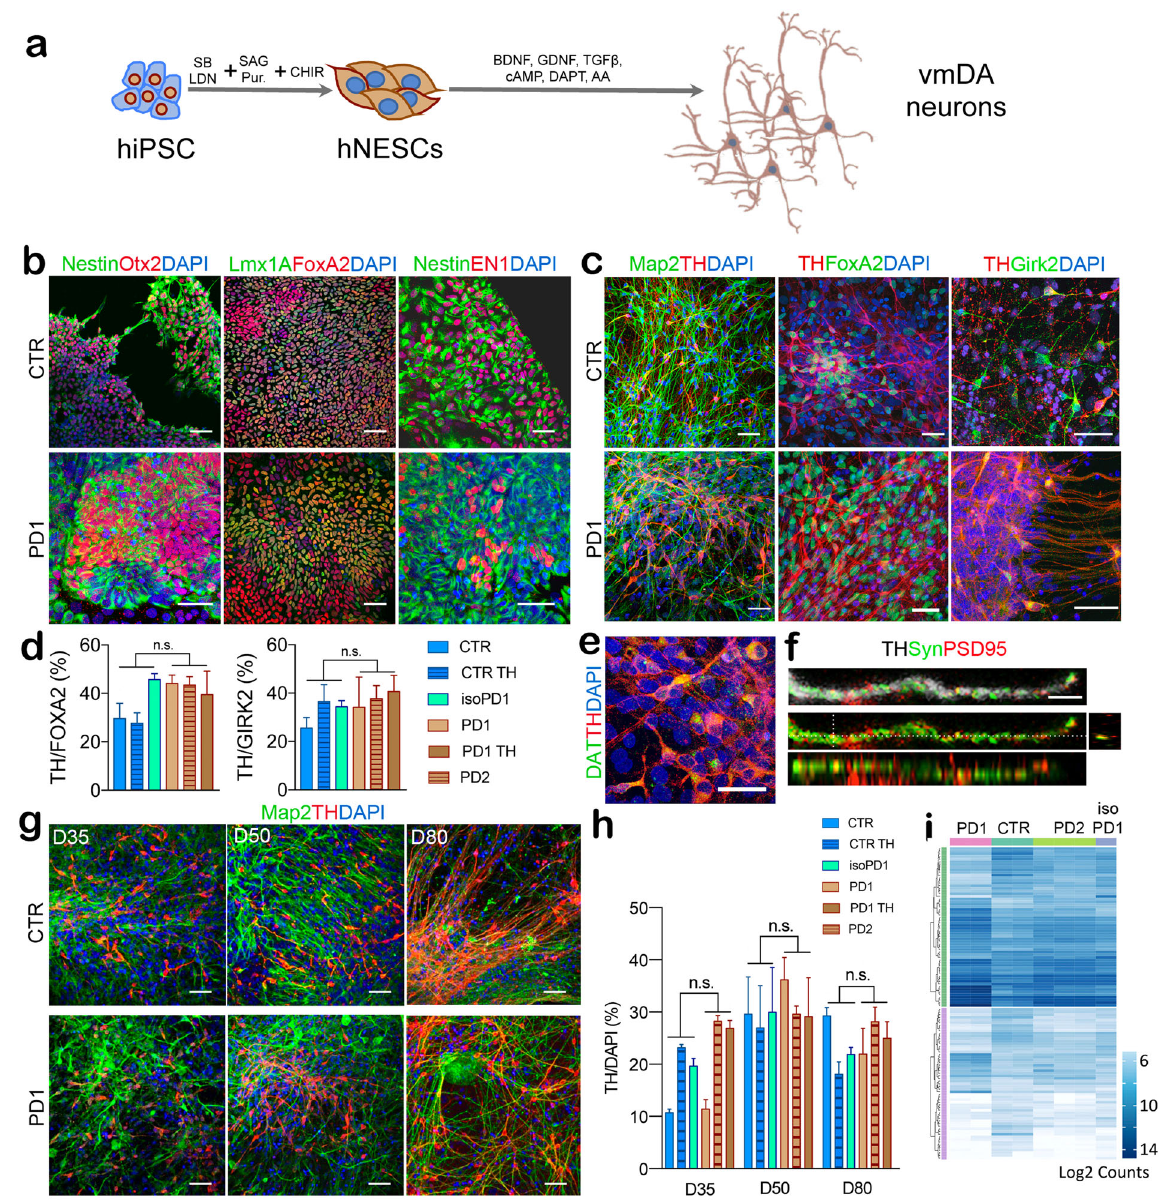
Fig. 1 Generation of ventral midbrain (VM) dopaminergic neurons from human iPSCs. a Scheme showing VM dopaminergic neurons differentiation protocol. b Representative immuno fl uorescence (IF) images of CTR (SP11) and PD1 (SP12) NPCs at day 12 of the differentiation process. iPSC-derived neural cultures express fl oor plate progenitor markers, such as Lmx1A, FoxA2, Otx2, Nestin, and EN1. c Representative IF images of CTR (SP11) and PD1 (SP12) differentiated neuronal cultures expressing neuronal markers (MAP2, TH) and midbrain-type DA markers (FoxA2 and Girk2) at day 50. Scale bar is 50 μ m. d Percentage of TH/FoxA2 and TH/Girk2 vmDAn at day 50 of all the lines [CTR (SP11), CTR TH (SP11 TH), gene-edited isoPD1 (SP12 wt/wt), PD1 (SP12), PD1 TH (SP12 TH), PD2 (SP13)]. A number of independent experiments n = 3. e – f Representative images of neuronal cultures at D50 expressing speci fi c markers of maturation: e DAT (dopamine transporter) (scale bar, 50 μ m); and f PSD95 (post-synaptic marker, red) and synapsin (synaptic marker, green). Orthogonal views show colocalization (scale bar, 10 μ m). g Representative images of CTR (SP11) and PD1 (SP12) neuronal culture at D35-D50 and D80 showing the expression of TH and MAP2 markers at the different timepoints. h Percentage of TH + cells over DAPI at the three different timepoints (D35-D50 and D80). i Heatmap of gene expression pro fi les of neuronal cultures of CTR (SP11), PD1 (SP12), PD2 (SP13), and gene-edited isogenic PD1 line (isoPD1) at D50, with dendrograms showing the strong similarities between independent experiments and the absence of clustering between control (CTR and isoPD lines, light brown) and PD (PD1 and PD2 lines, blue) conditions. Shown are transcripts with ≥ 2-fold change in expression, grouped as upregulated (50 transcripts, green bar) or downregulated (107 transcripts, purple bar). No statistically signi fi cant differences were found at p-Adj ≤ 0.1 when comparing control and PD conditions. Each type of culture was analyzed a minimum of 2 independent times, except for the gene-edited isogenic PD1 line, for which only one RNA preparation passed the quality control and could be Sharp increases in the fl uorescence traces (Fig. 2a) revealed (Fig. 2b) and observed that all lines evolved similarly, indicating spontaneous neuronal activations, which were analyzed to extract that any anomalies in PD networks would depend on the structure the onset times of elicited action potentials. With these data we of the activity patterns, rather than on the strength of activity fi rst computed the average neuronal activity along culture time itself. Thus, we next computed the Global Network Activity (GNA),